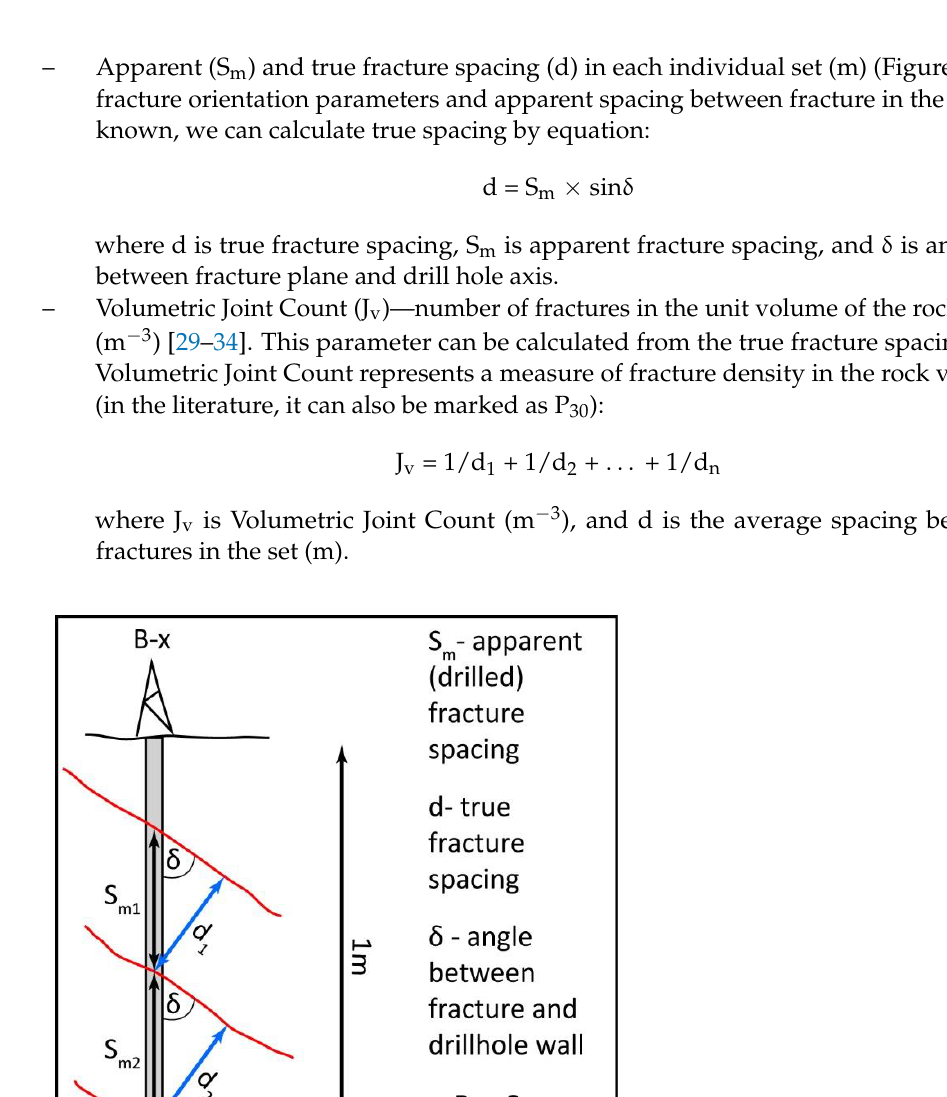
Table 1. Fracture orientation data and fracture set interpretation.